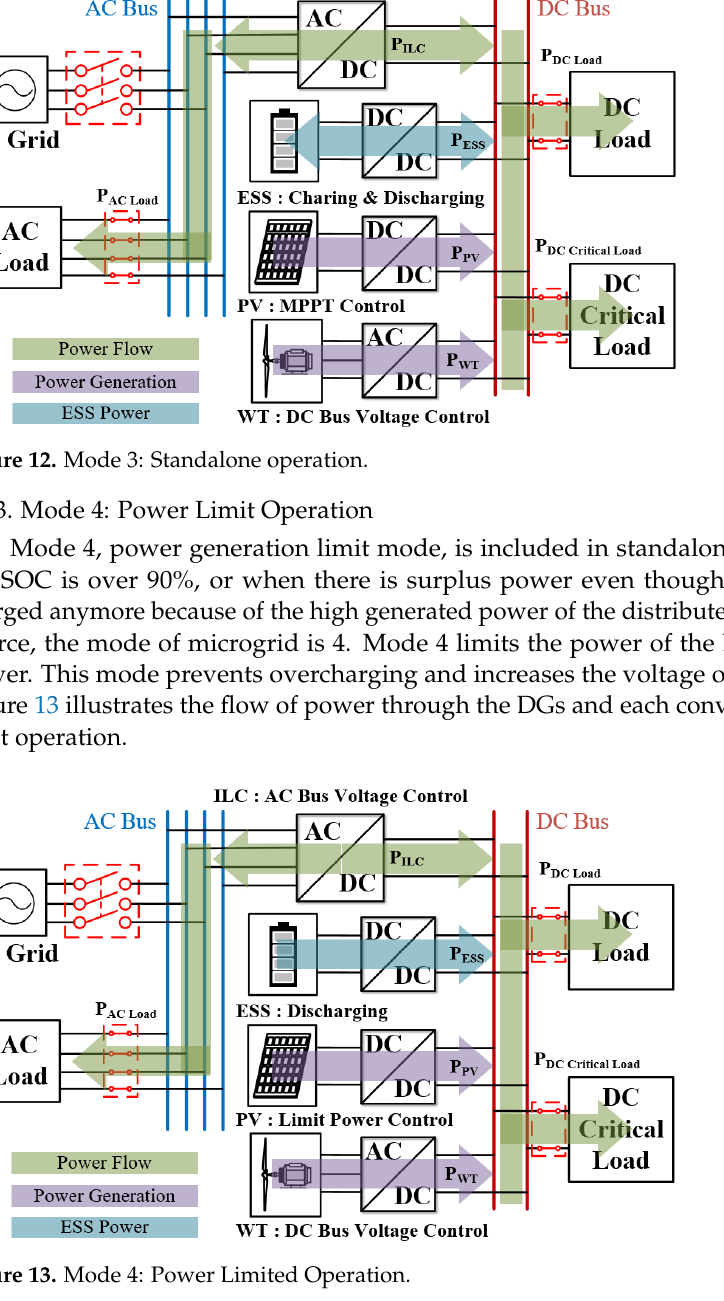
Figure 13. Mode 4: Power Limited Operation.